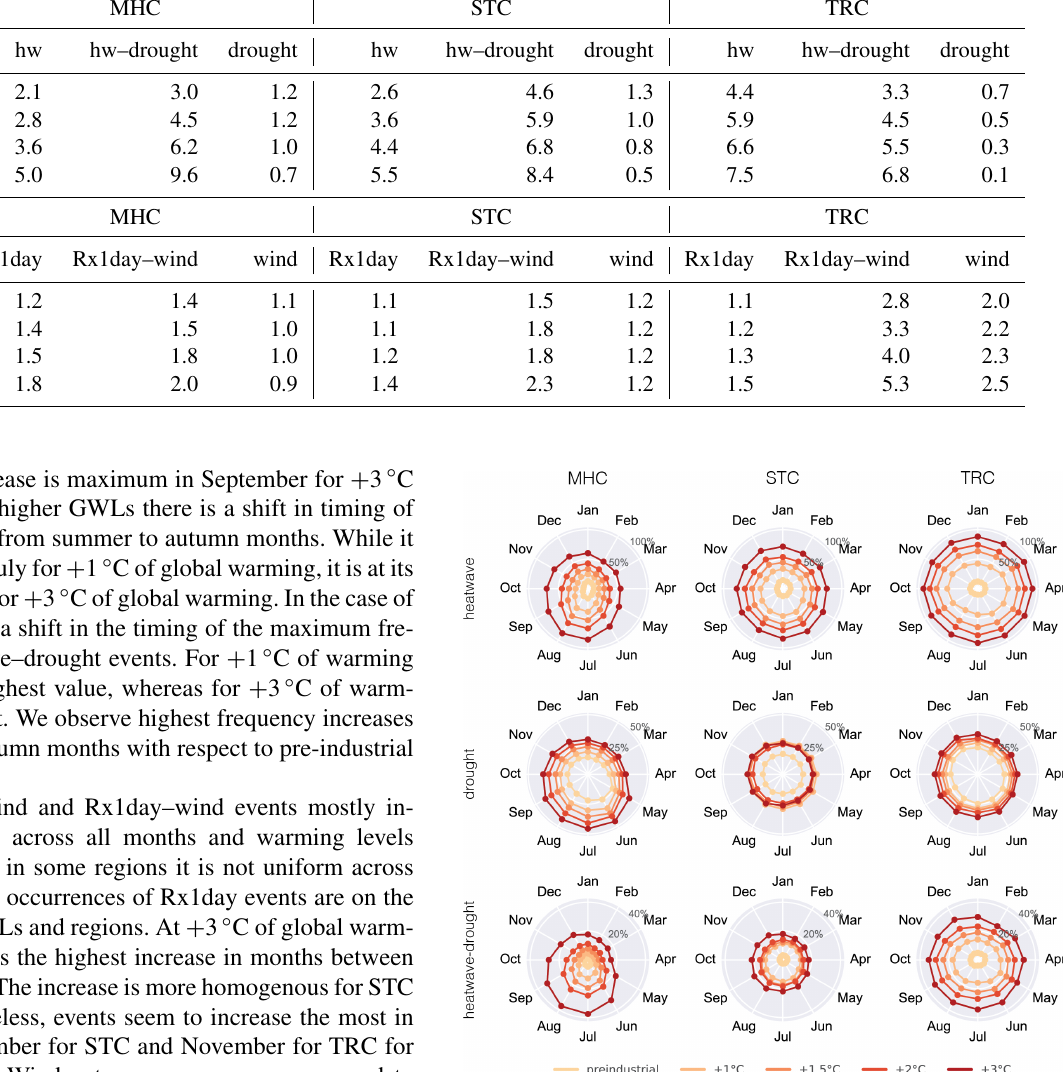
Table 1. Increase in isolated and concurrent events at global warming levels relative to pre-industrial levels. Heatwave is denoted by ”hw”. MHC STC TRC hw hw–drought drought hw hw–drought drought hw–drought